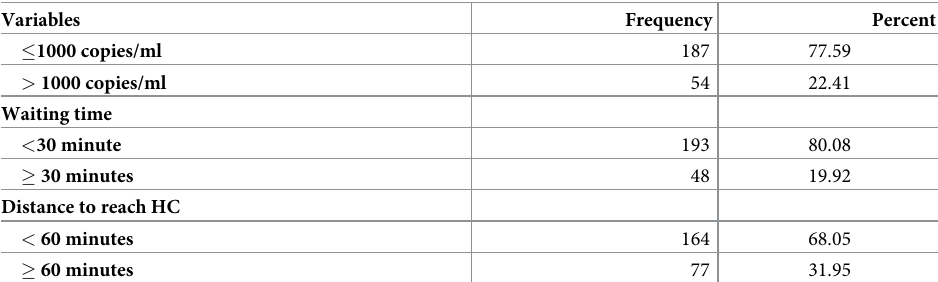
Factors associated with satisfaction of pediatric ART client caregiver. In this study, the sex of caregivers, distance to the health facility, and viral load were significantly associated with caregivers’ satisfaction with ART services.